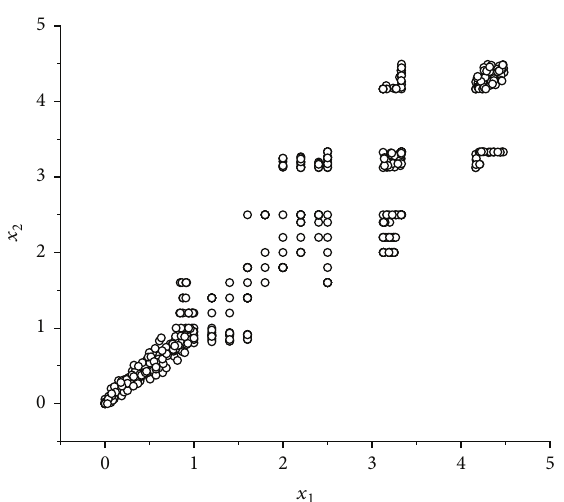
Figure 3: The obtained non-dominated solutions of M-BINH problem with reference points, projected in objective space.